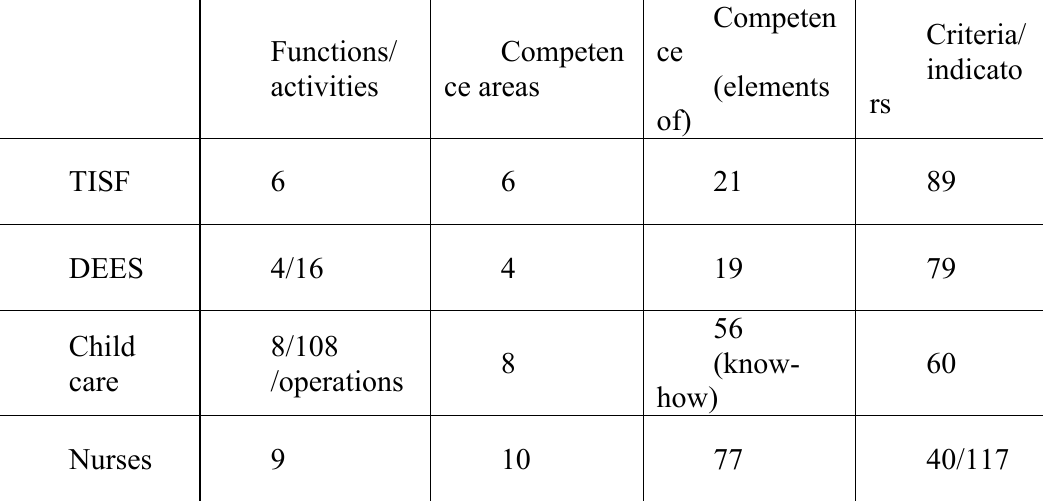
Table 1 : Quantitative data regarding the reference documents (référentiels) for the professions